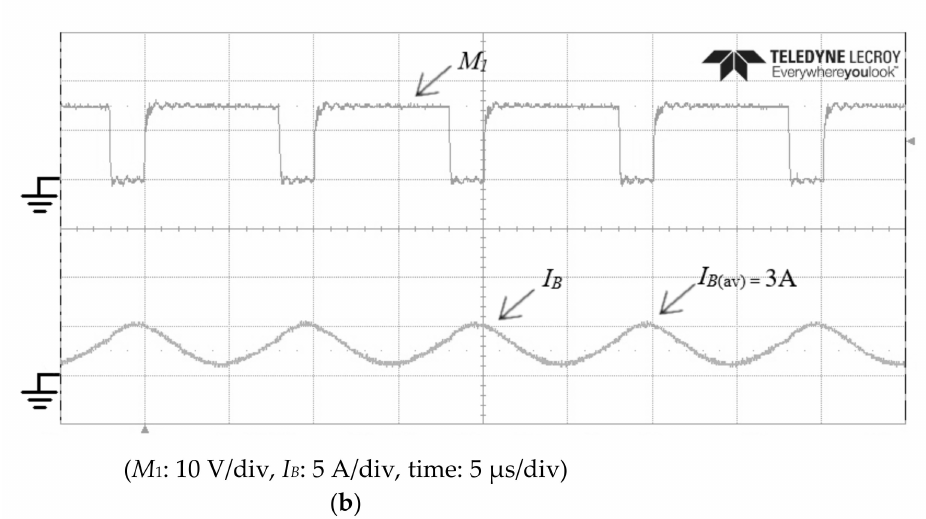
Figure 18. Measured gate voltage M 1 and charging current I B of the proposed hybrid converter operated in the charging mode: ( a ) under the average charging current I B(av) = 0.7 A, and ( b ) under I B(av) = 3 A.